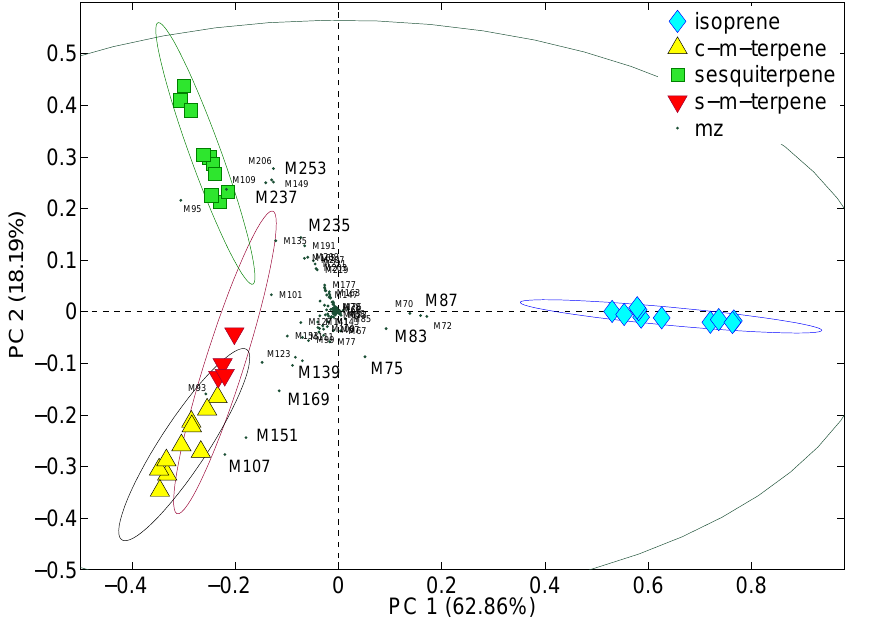
Figure 2. PCA loadings bi-plot of the second vs. first principal components derived from the PCA analysis of the isoprene, cyclic monoterpene (c-m-terpene in the legend; α -pinene and limonene), sesquiterpene ( β -caryophyllene) and straight chain biogenic (s-m- terpene in the legend; myrcene and linalool) chamber data. Classification confidence level is 95%. Tentative assignments of major ions, include m/z 71 – methyl vinyl ketone and methacrolein, 75 – hydroxy acetone, 83 – C 5 -hydroxy carbonyls/3-methyl furan, 87 – C 4 - hydroxycarbonyls/methacrylic acid, m/z 237 – β -caryophyllene aldehyde, 235 and 253 – β -caryophyllene secondary ozonide (and isomers thereof), m/z 107, 151 and 169 – piononaldehyde and limononaldehyde, 139 – limonaketone, m/z 93 – 4-vinyl-4-pentenal and 4-hydroxy- 4-methyl-5-hexen-1-al. See main text (Sect. 4.2 and Table 3) for further information. For clarity, the scale has been set to show the bulk